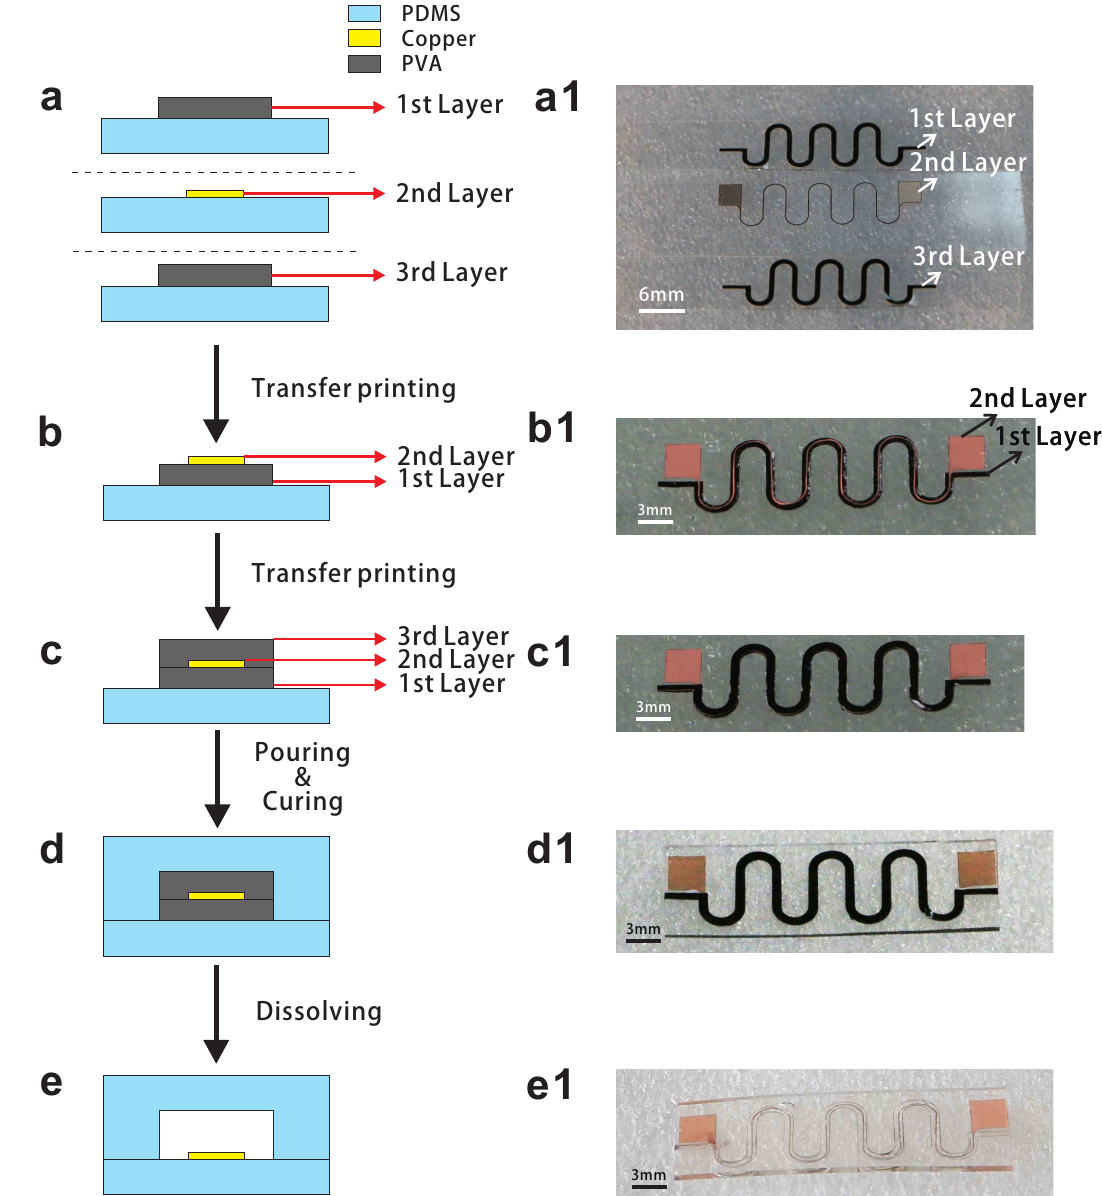
Figure 1. Schematic diagram of the tunnel encapsulation fabrication process. ( a ) Patterned copper foil and PVA membrane, where the first layer and the third layer have the same dimension. ( a1 ) Optical image of patterned copper film and PVA. ( b ) Metal circuit was transferred to the patterned